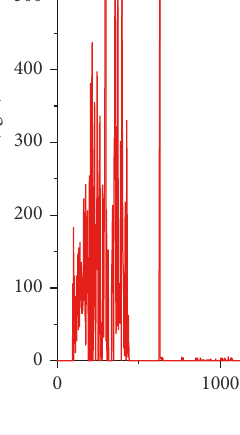
Figure 22: Accumulator-2 injection